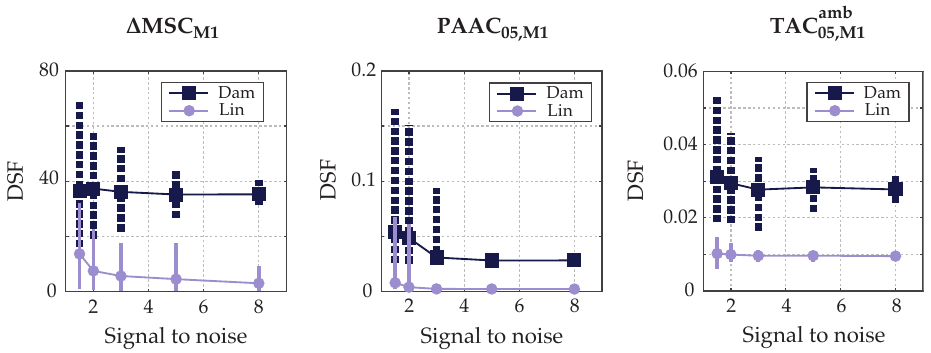
Figure 15. Influence of measurement noise, expressed as the signal-to-noise ratio, on the DSF values derived from AVs.